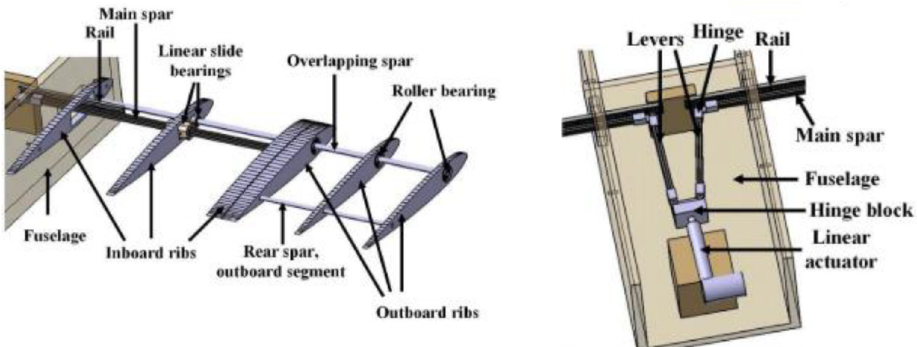
Figure 2. ASAPP wing internal structure ( left ) and actuation mechanism ( right ) [9].